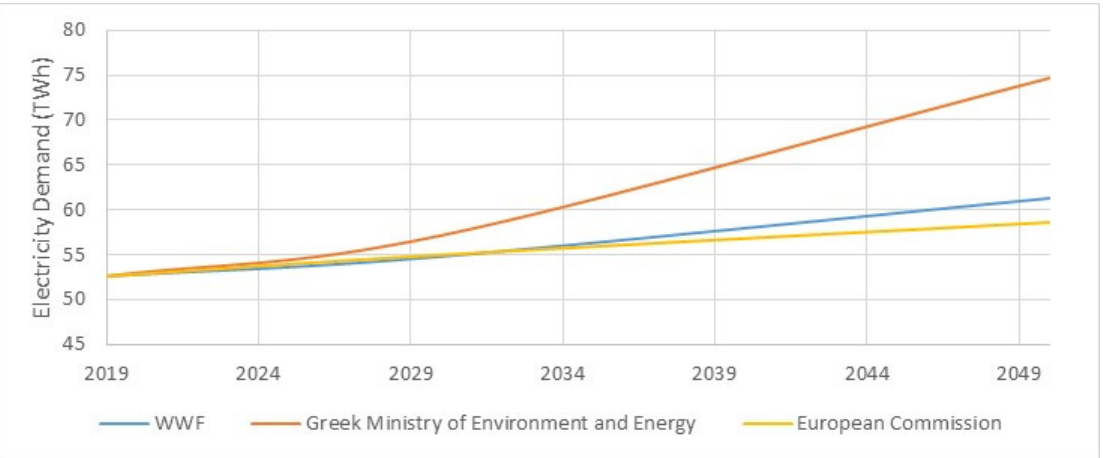
Figure 5. Electricity demand development scenarios [27–29].